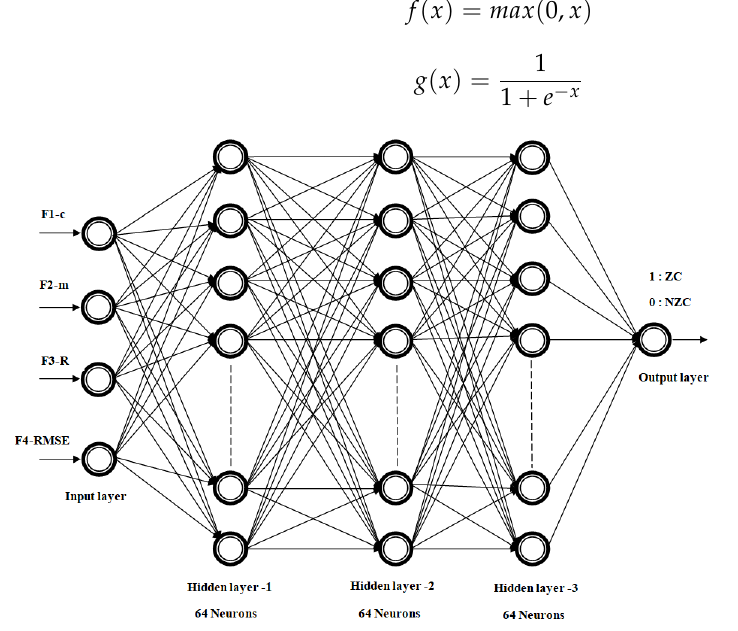
Figure 6. DNN model topology. Table 1. DNN model